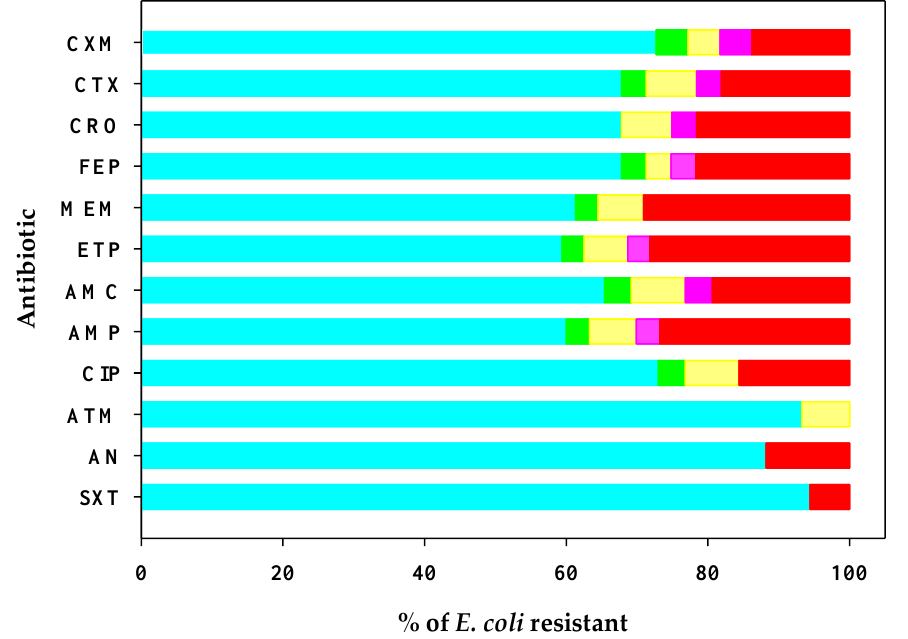
Figure 2. Antimicrobial resistance depends on sampling E. coli isolates from irrigation water, harvested melon, packing workers’ hands, cardboard packing boxes, and discarded melon from the Honeydew melon farm and packing facility in Hermosillo, Sonora. Ce- furoxime (CXM), cefotaxime (CTX), ceftriaxone (CRO), cefepime (FEP), meropenem (MEM), ertapenem (ETP), amoxicillin/clavulanic acid (AMP), ampicillin (AMP), ciprofloxacin (CIP), aztre- onam (ATM), amikacin (AN), and sulfamethoxazole/trimethoprim (STX).